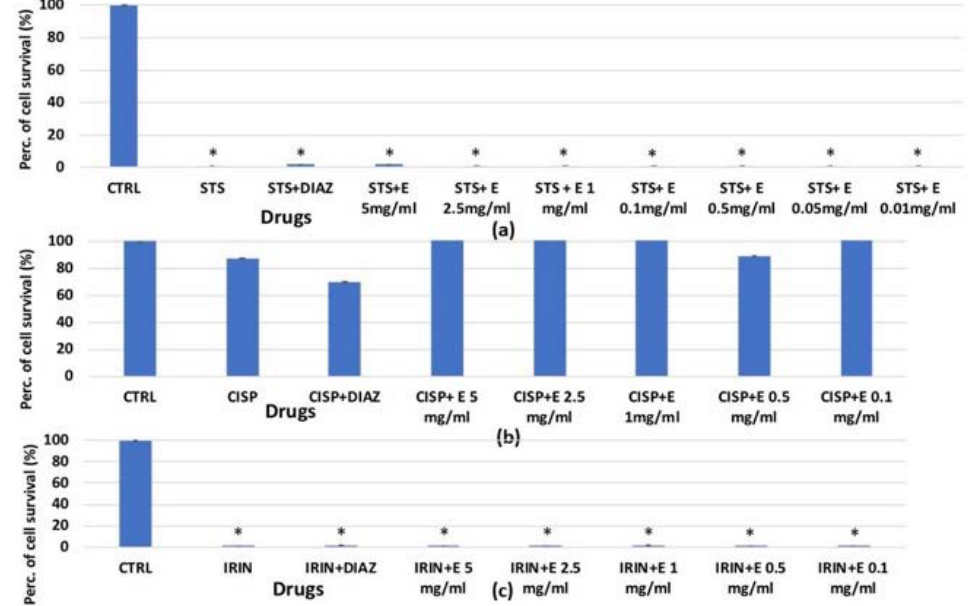
Figure 9. Percentage of cell growth values for HEK293 cells co-incubated ( a ) 6 h with staurosporine 2.14 × 10 − 6 M (STS); ( b ) 72 h with cisplatin 1 × 10 − 4 M (CISP); ( c ) 72 h with irinotecan 1 × 10 − 4 M (IRIN)